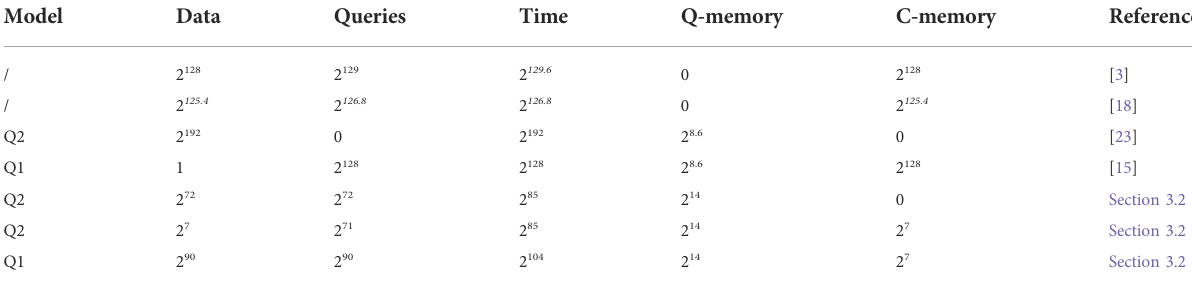
TABLE 4 Comparison of attacks against AES 2 .